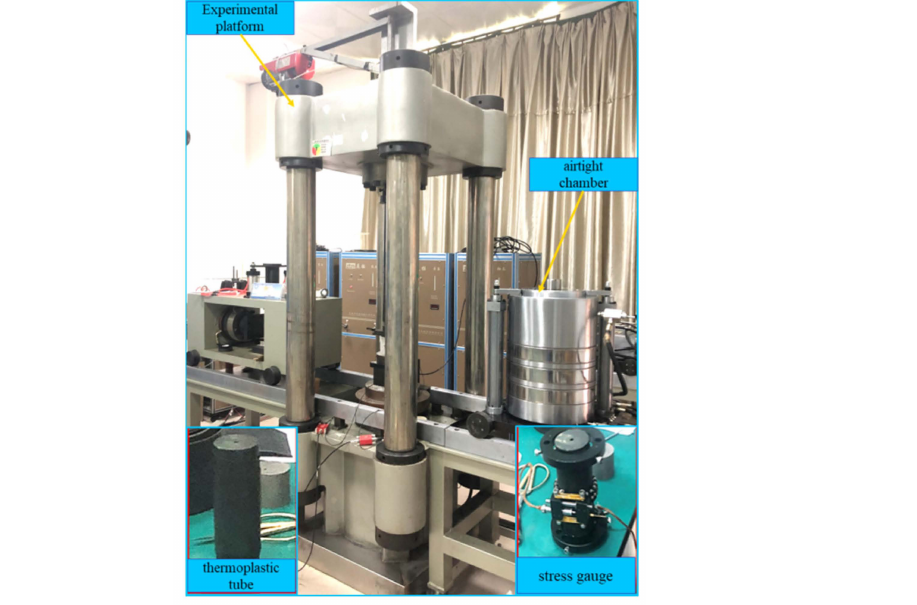
Figure 4. Experimental instrument.